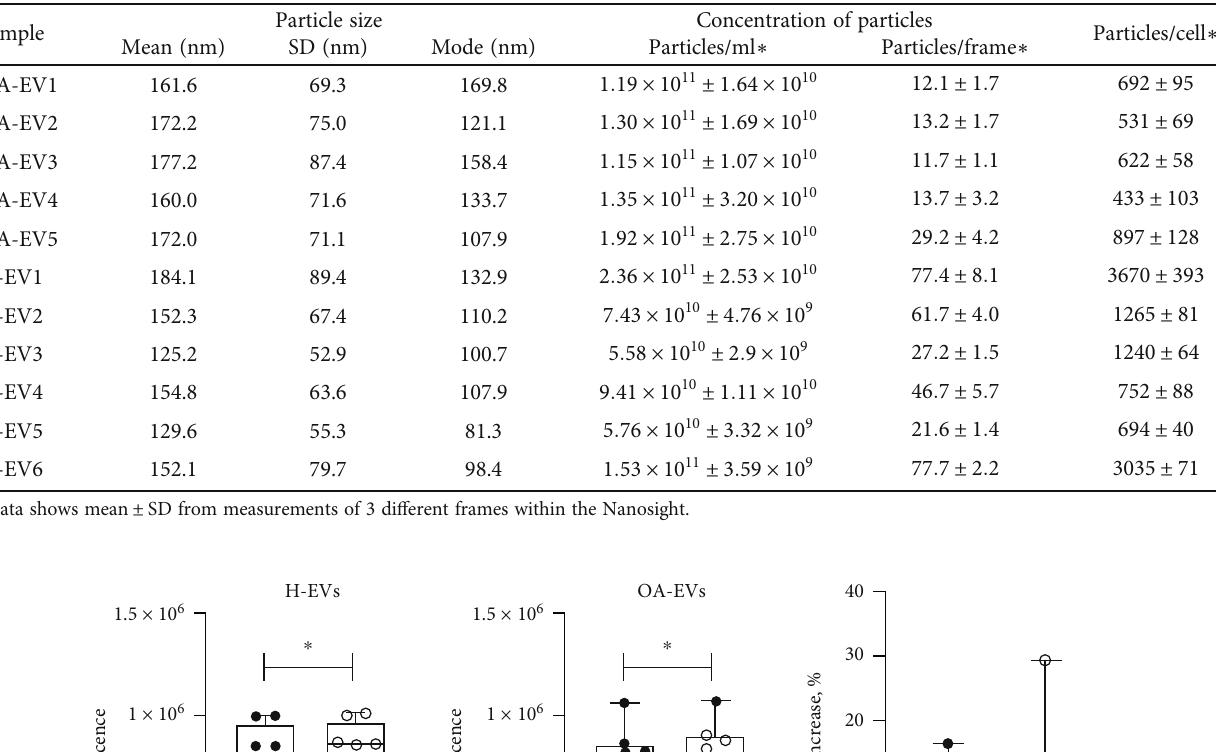
Table 2: Summary of EV characteristics isolated from OA and healthy MSCs: particle size, concentration of particles, and the number of cells from which EVs were obtained.